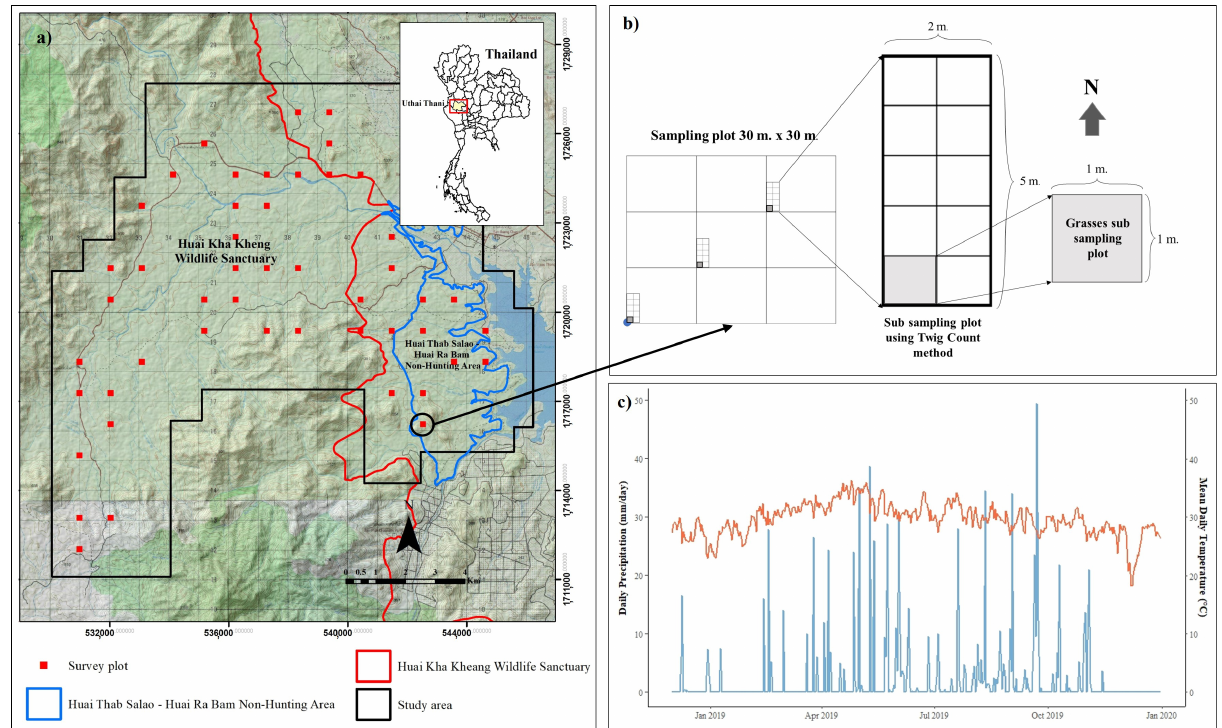
Figure 2. ( a ) Map of the study area in Huai Kha Khaeng Wildlife Sanctuary and Huai Thab Salao-Huai Rabum Non-Hunting Area, Uthai Thani, Thailand; red squares indicate the location of the forty-eight 30 × 30 m 2 sampling plots; ( b ) diagram of sampling scheme at each of the 30 × 30 m 2 sampling plots. All of the environmental factors were quantified at the 30 × 30 m 2 plot. The forage availability was calculated from destructive samplings at two scales: (1) The 2 × 5 m 2 sub sampling plot for forbs, shrubs, and seedlings with the Twig Count method, and (2) The 1 × 1 m 2 sub sampling plot for grass with the direct harvest; ( c ) climate graph of the study area. The blue line shows daily precipitation (mm/day), and the red line shows mean daily temperature